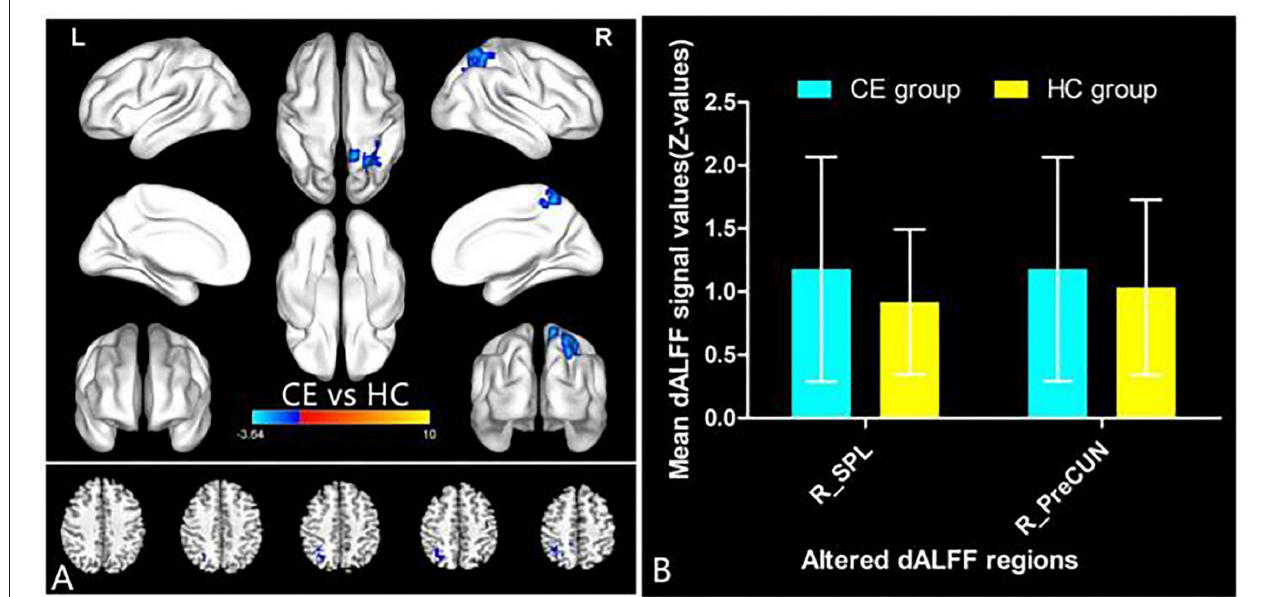
FIGURE 2 | dALFF differences between two groups (window length = 30 TR, window step = 1 TR) (A) . The mean of altered dALFF values between two groups (B) . CE, comitant exotropia; HC, health control; dALFF, dynamic amplitude of low-frequency fluctuation; SPL, superior parietal lobule; PreCUN, precuneus; R, right.